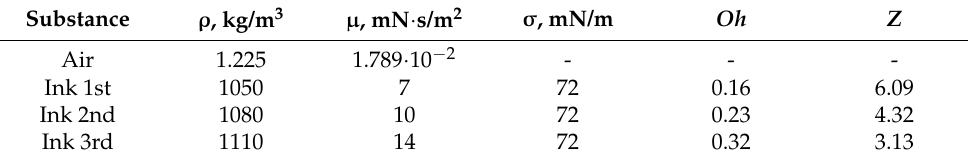
Table 1. Physical parameters of ink and air used in modeling the inkjet nozzle. Substance